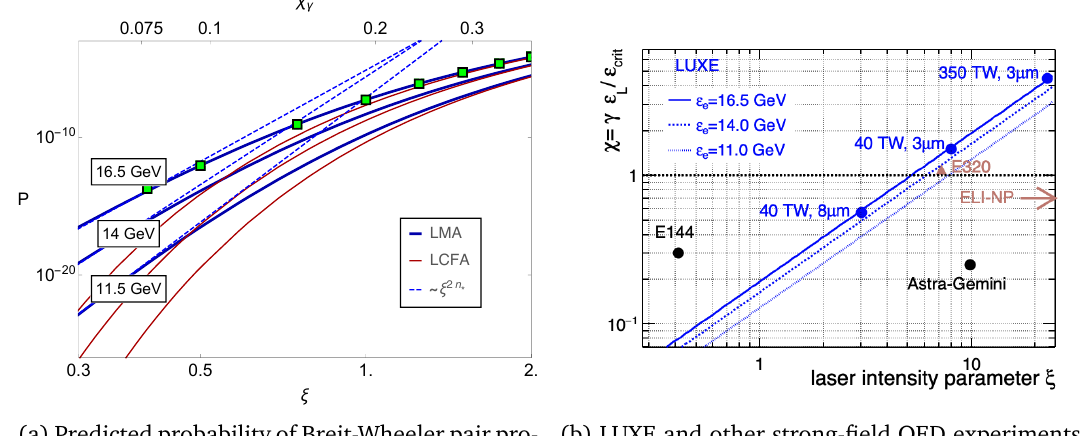
(b) LUXE and other strong-field QED experiments in the strong-field QED parameter space [ 8 ]